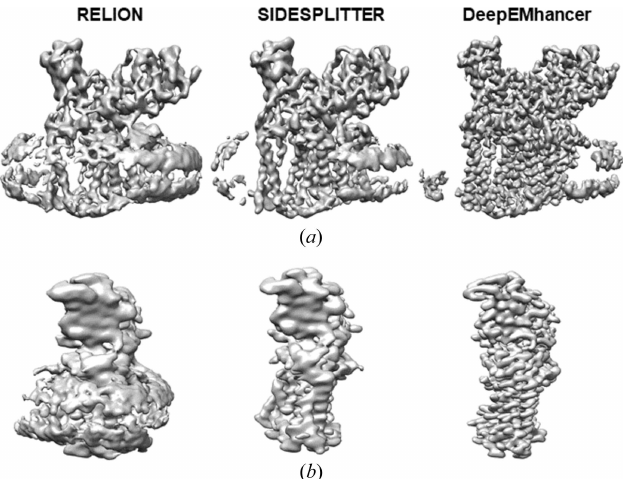
Figure 4 Refinements of 57970 particle images of EmbB in lipid nanodiscs (EMPIAR-10420). Comparison of refinement results using standard RELION , SIDESPLITTER and deepEMhancer . No local filtering or sharpening operations were used and the threshold was set to keep the enclosed volume constant. ( a ) Side view and ( b ) alternative side view of the